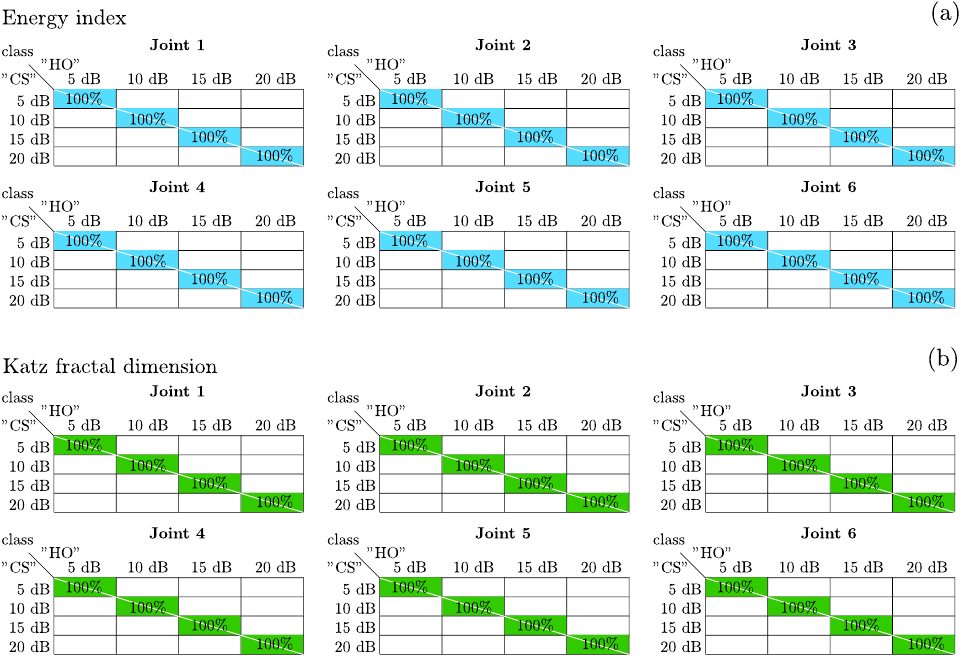
Figure 13. Confusion matrix average accuracy of half- and full-speed cases, using specific noise level samples for validation: ( a ) results corresponding to energy index classification; ( b ) results corresponding to Katz fractality